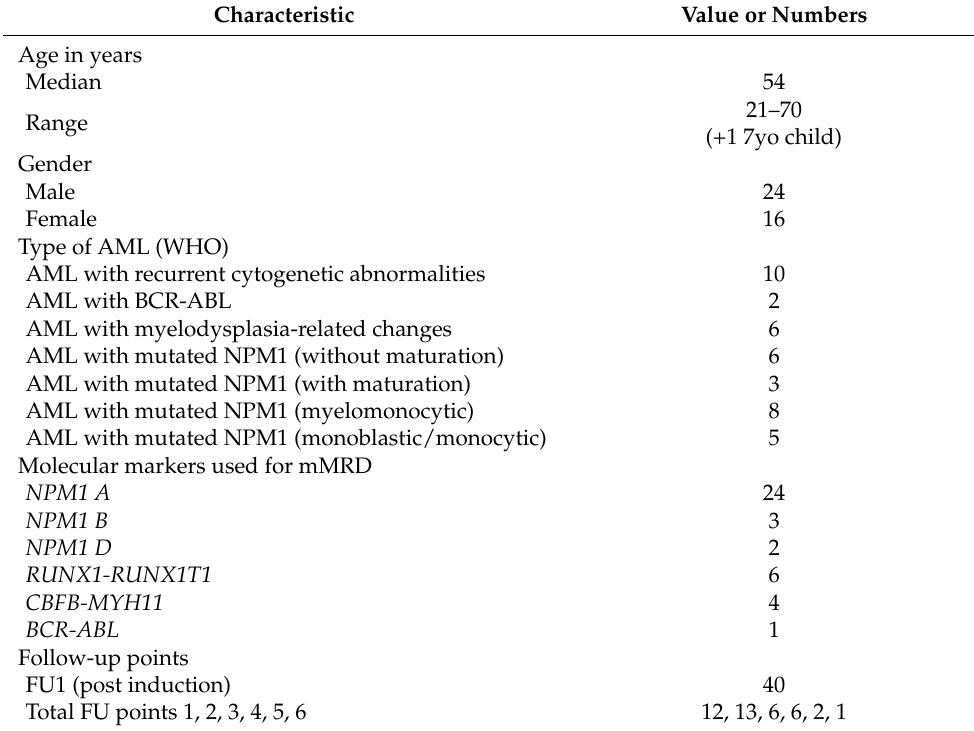
Table 1. Patient